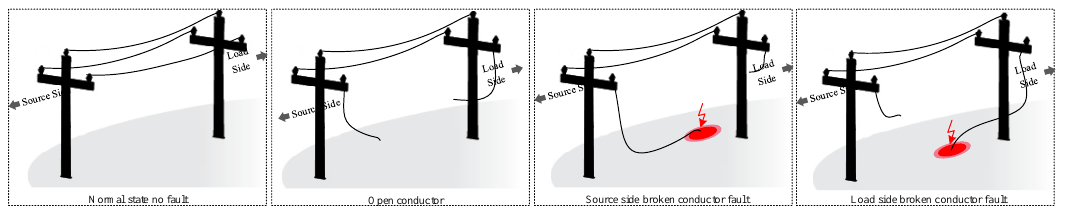
Figure 2. The conditions of normal state and broken conductor faults.